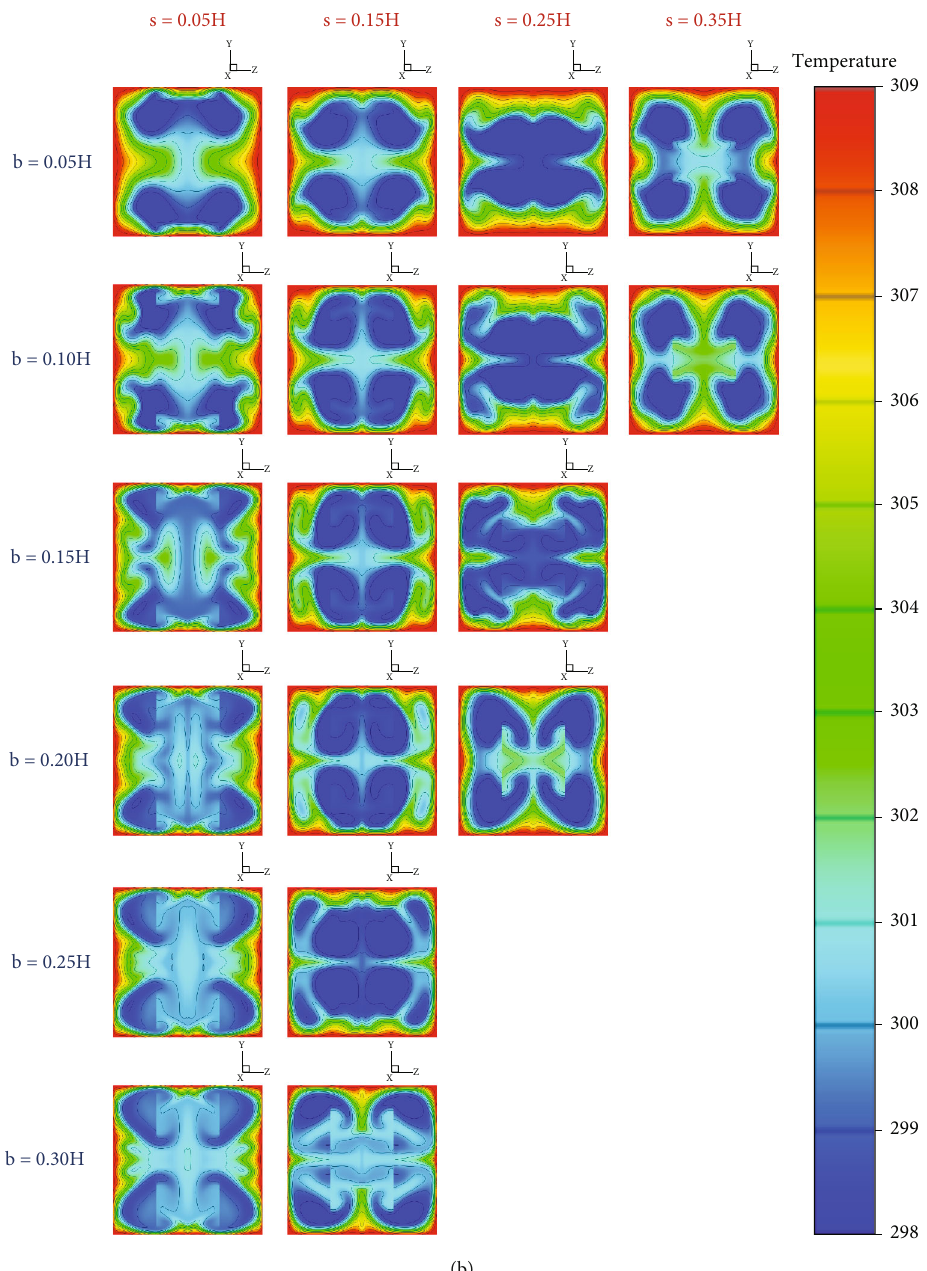
Figure 7: Temperature contours in cross-sectional planes for the ba ffl ed duct with various b / H and s / H at Re = 800 of (a) VD and (b)